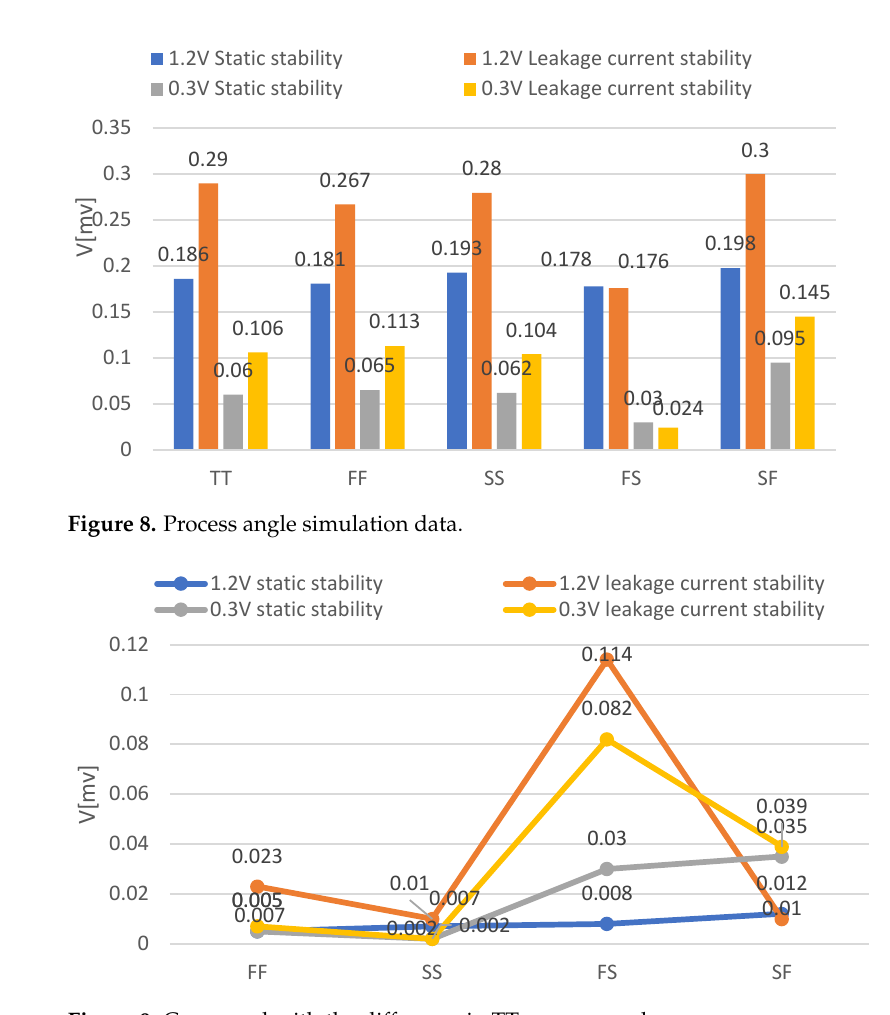
Figure 9. Compared with the difference in TT process angle.